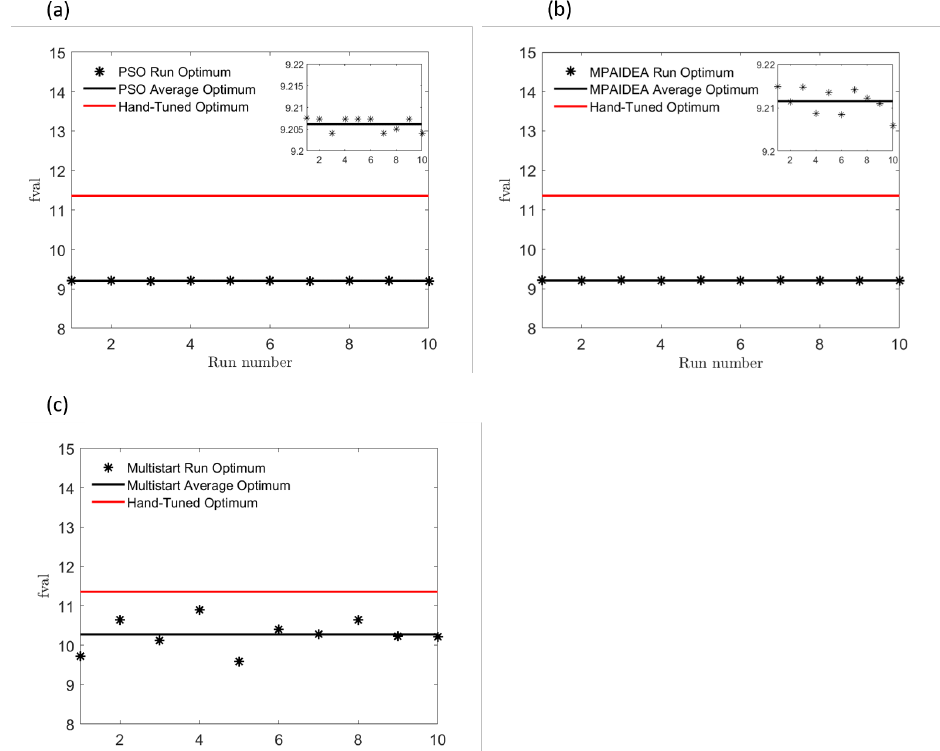
Figure 8. Objective function value range across 10 runs ( a ) PSO ( b ) MP-AIDEA ( c )